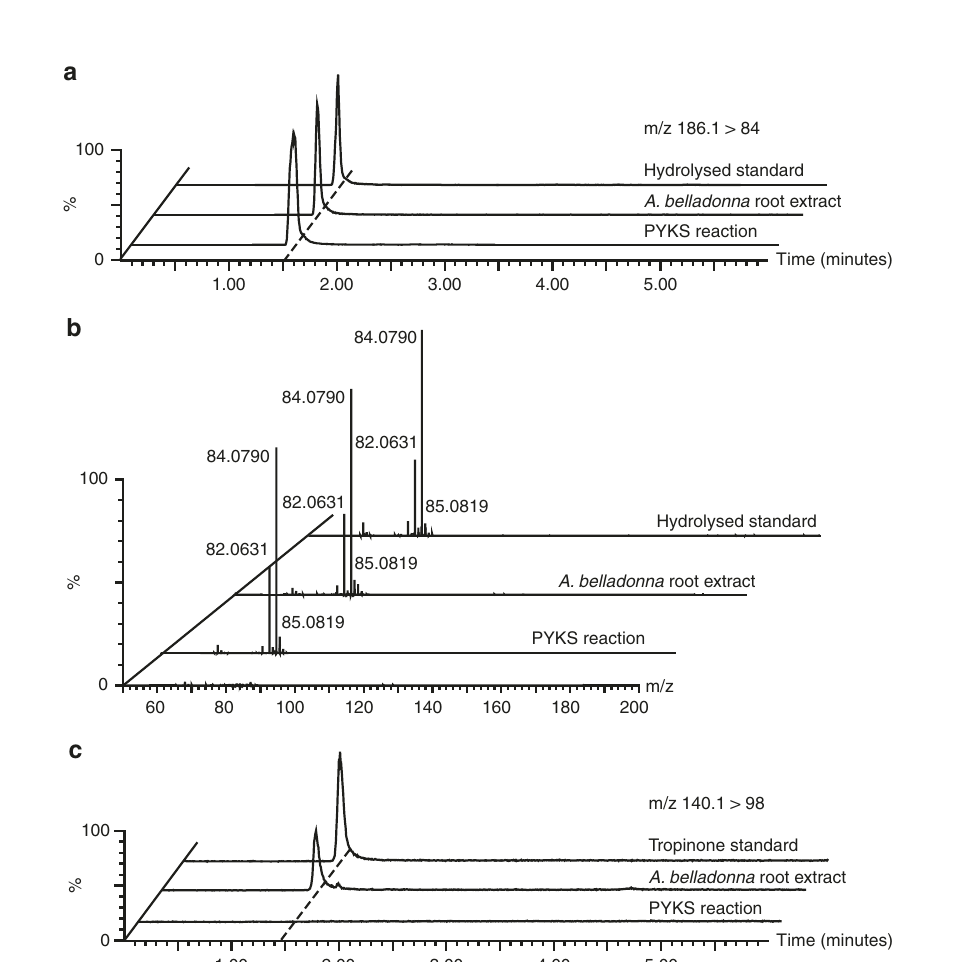
Fig. 1 Silencing of a root-expressed type III polyketide synthase reduces tropane and pyrrolidine alkaloid levels. a The tropane and pyrrolidine alkaloid biosynthetic pathway in the Solanaceae starting from putrescine ( 1 ). Experimentally validated enzymes are shown in blue, AbPYKS is noted in red, and unknown reactions are noted with question marks. Enzyme abbreviations are as follows: PMT; putrescine methyltransferase, MPO; methylputrescine oxidase, TRI; tropinone reductase I, TRII; tropinone reductase II; CYP80F1; littorine mutase, H6H; hyoscyamine-6-hydroxylase. b Abundance of tropane and pyrrolidine alkaloids together with selected precursors in TRV2 empty vector control lines (cyan bars) and TRV2:ab1322 ( AbPYKS ) VIGS lines (green bars). Data are presented as the mean n = 24 biological replicates for TRV2 empty vector control lines and n = 23 for TRV2:ab1322 ( AbPYKS ) VIGS lines. Asterisks denote signi fi cant differences (*** p < 0.001) as determined by Student ’ s t test. This experiment was replicated twice. For each box plot, the lower and upper bounds of the box indicate the fi rst and third quartiles, the line indicates the median value, and the whiskers extend to the minimum and maximum data points. Source Data are provided as a Source Data fi le